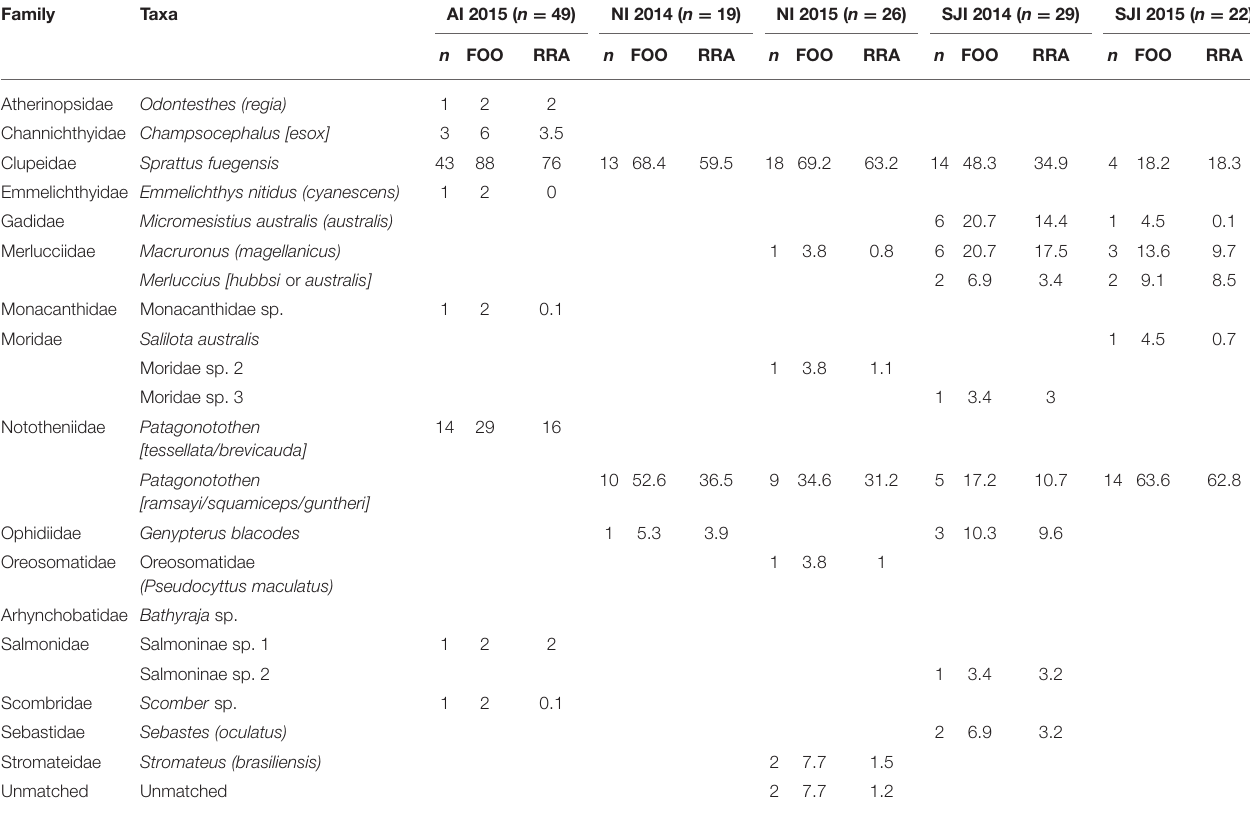
TABLE 5 | Fish prey of black-browed albatrosses at Albatross Islet (AI), Chile; and New Island (NI) and Steeple Jason Island (SJI), Falkland Islands. Family